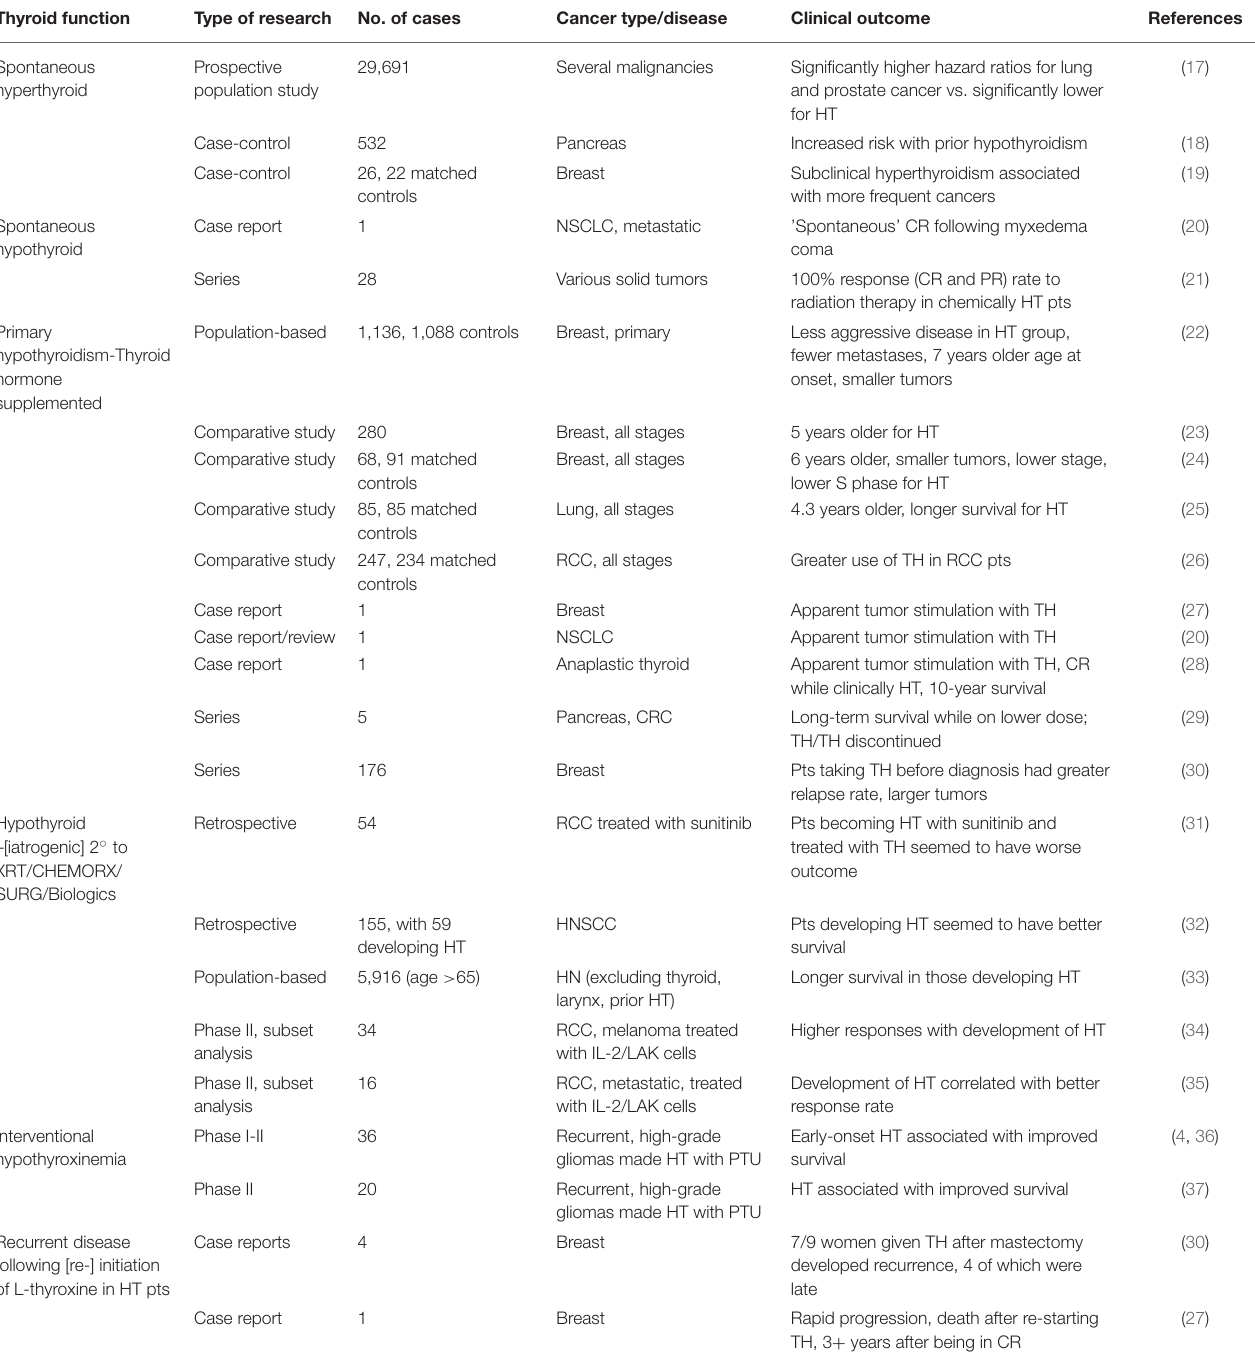
TABLE 1 | Cancer outcomes across a spectrum of thyroid